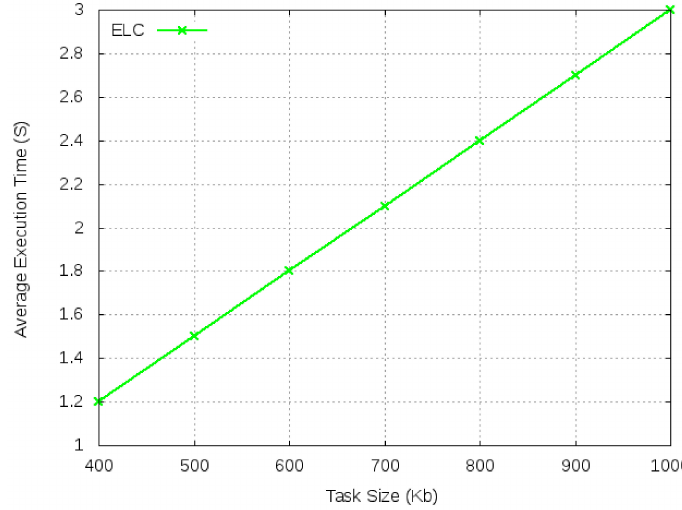
Figure 8. Average execution time for ELC with varied task